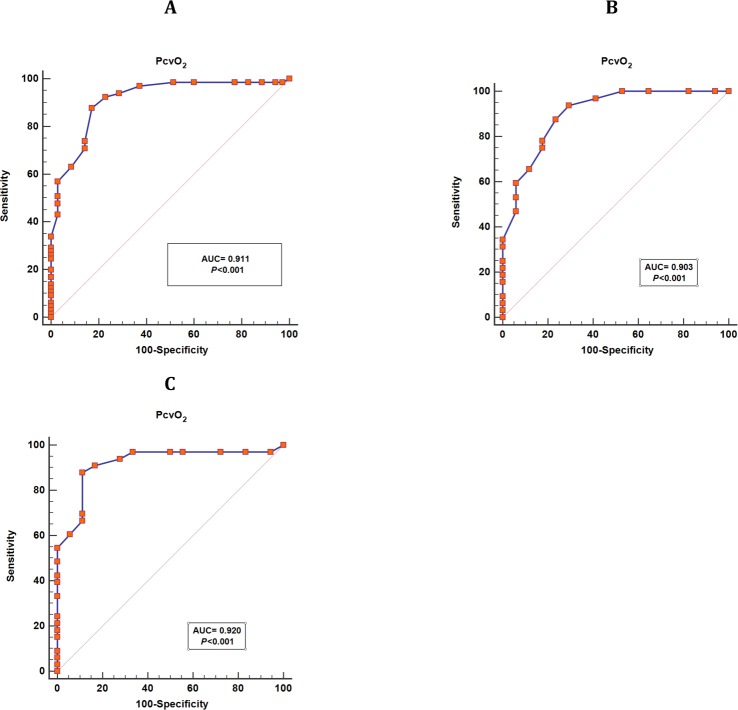
Receiver operator characteristic (ROC) curve showing the ability of the central venous oxygen pressure (PcvO2) to predict Co-oximetry ScvO2 greater than or equal to 70% in all patients.(A) The whole population, (B) Septic shock patients, and (C) Non-septic shock patients.